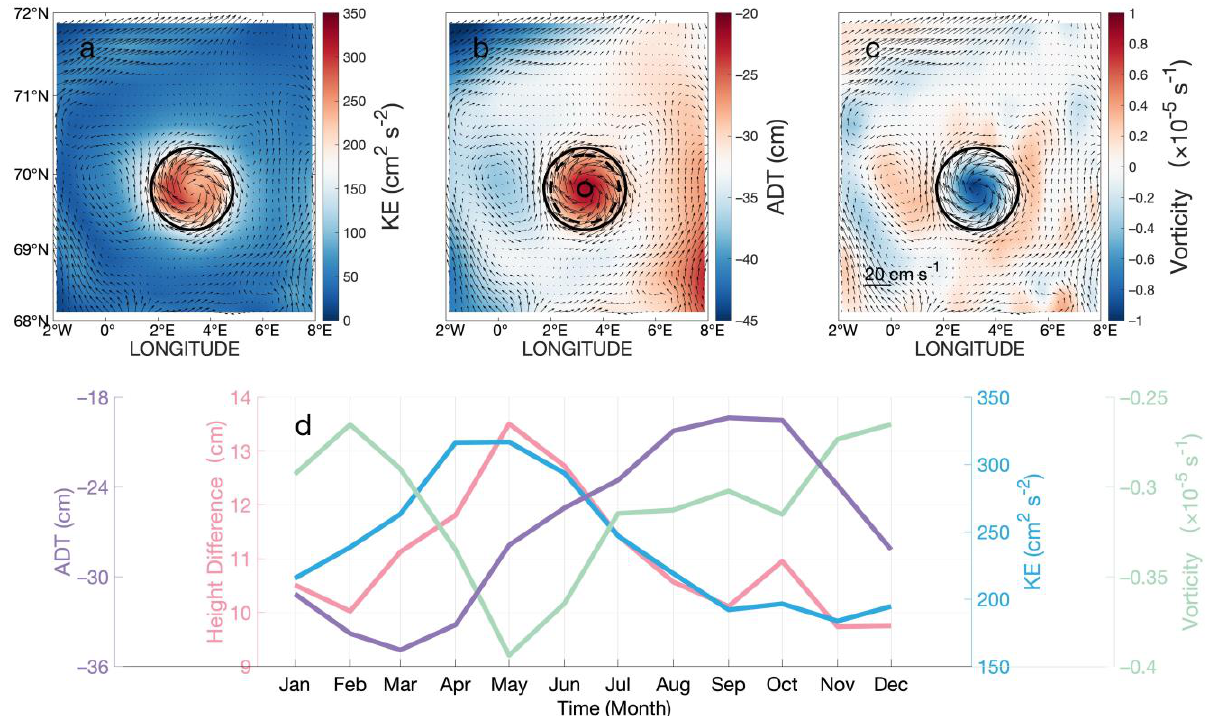
Figure 3. Spatial graphics of the climatological ( a ) kinetic energy, ( b ) ADT, and ( c ) vorticity of the CLV derived using daily AVISO sea-level data from 01-01-1993 to 09-02-2022. ( d ) Climatological monthly variation in the ADT, height difference, kinetic energy, and vorticity in the CLV. The height difference is the amplitude between the mean height within the black circle with a radius of 10 km and the mean height within the dashed ring with a radius of 50–60 km. The other parameters are averaged within the circle with a radius of 60 km.